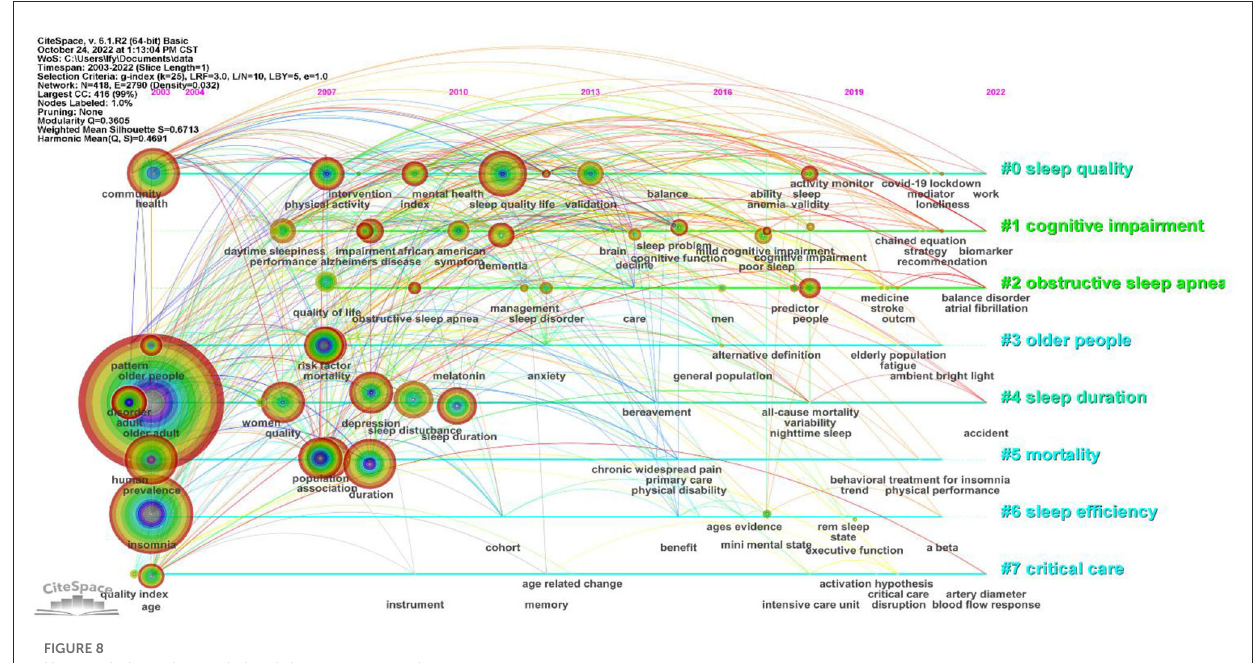
FIGURE8 Keyword clustering and visual time-zone